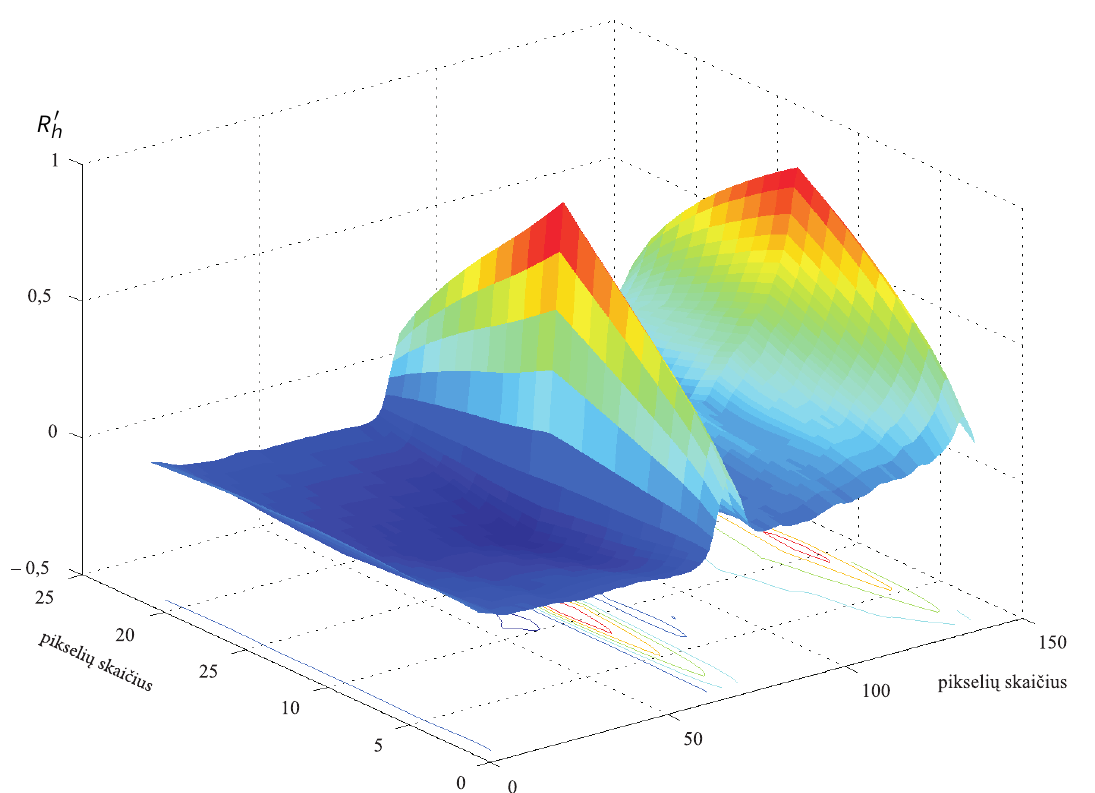
Fig. 1. Graphical view of the correlation coefficient matrix of the two digital